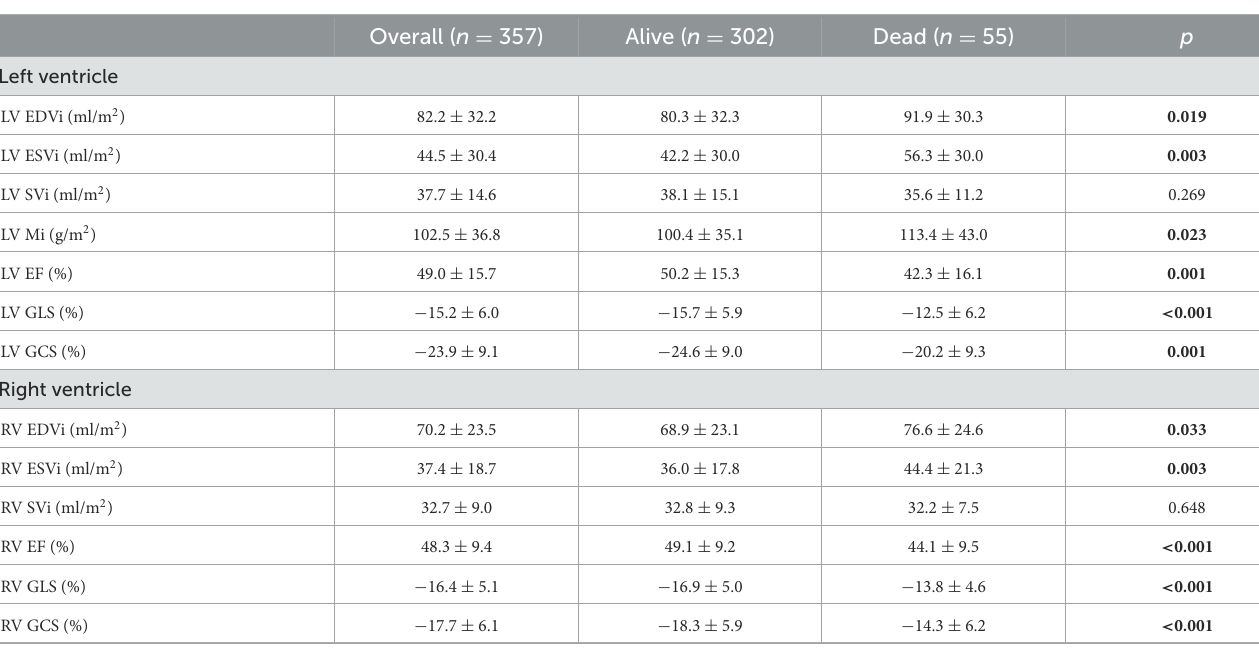
TABLE 2 3D echocardiographic parameters.